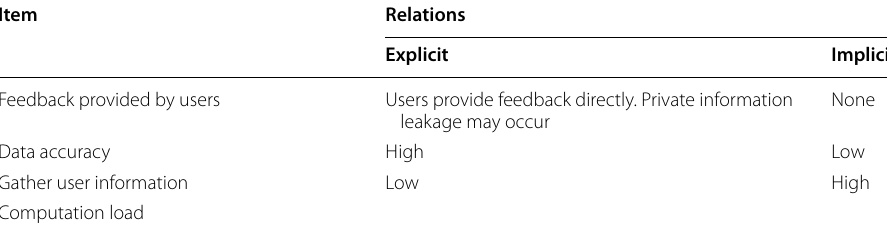
Table 1 Recommender system comparison